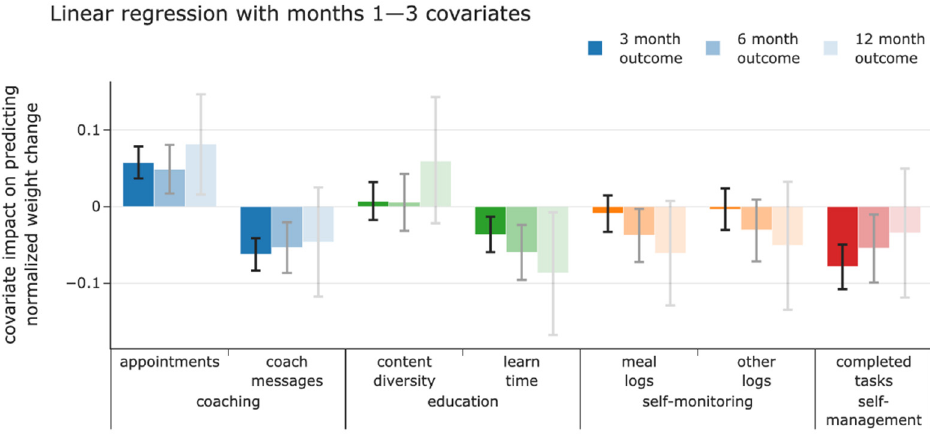
Figure 2. Contribution of the HCP-element (blue) and digital intervention elements (green, yellow, red) to weight losses at 3, 6, and 12 months (including 95% credibility intervals for estimated coefficients based on their posterior probabilities). Ordinate units are in standard deviation of the relative weight change divided by the standard deviation of each covariate, respectively. For example, a user with 1 standard deviation above average learn time during the first 3 months, is predicted to achieve 0.04, 0.06, or 0.09 standard deviations above average weight loss at months 3, 6, or 12, respectively.